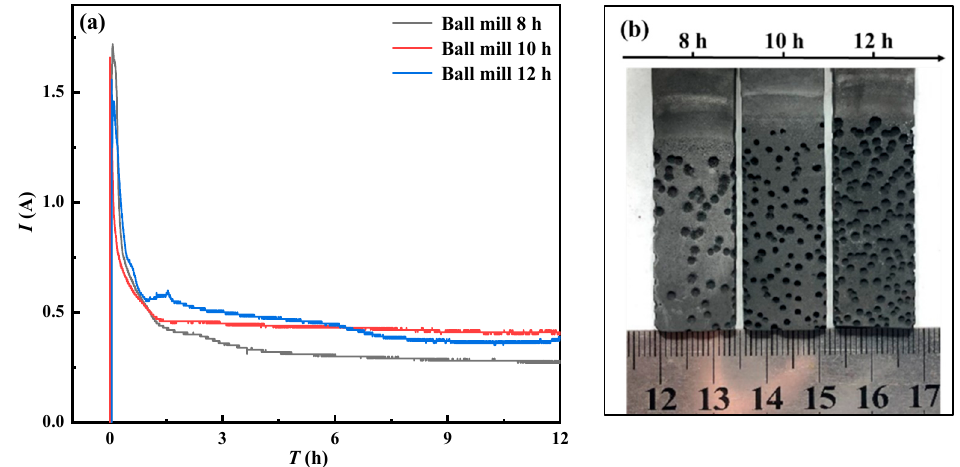
Figure 9. I – t curve of mixed oxide cathode after electrolysis at 3.2 V constant voltage in 800 °C CaCl 2 –NaCl molten salt for 12 h (a) and the graph of graphite sheet after electrolysis (b) .